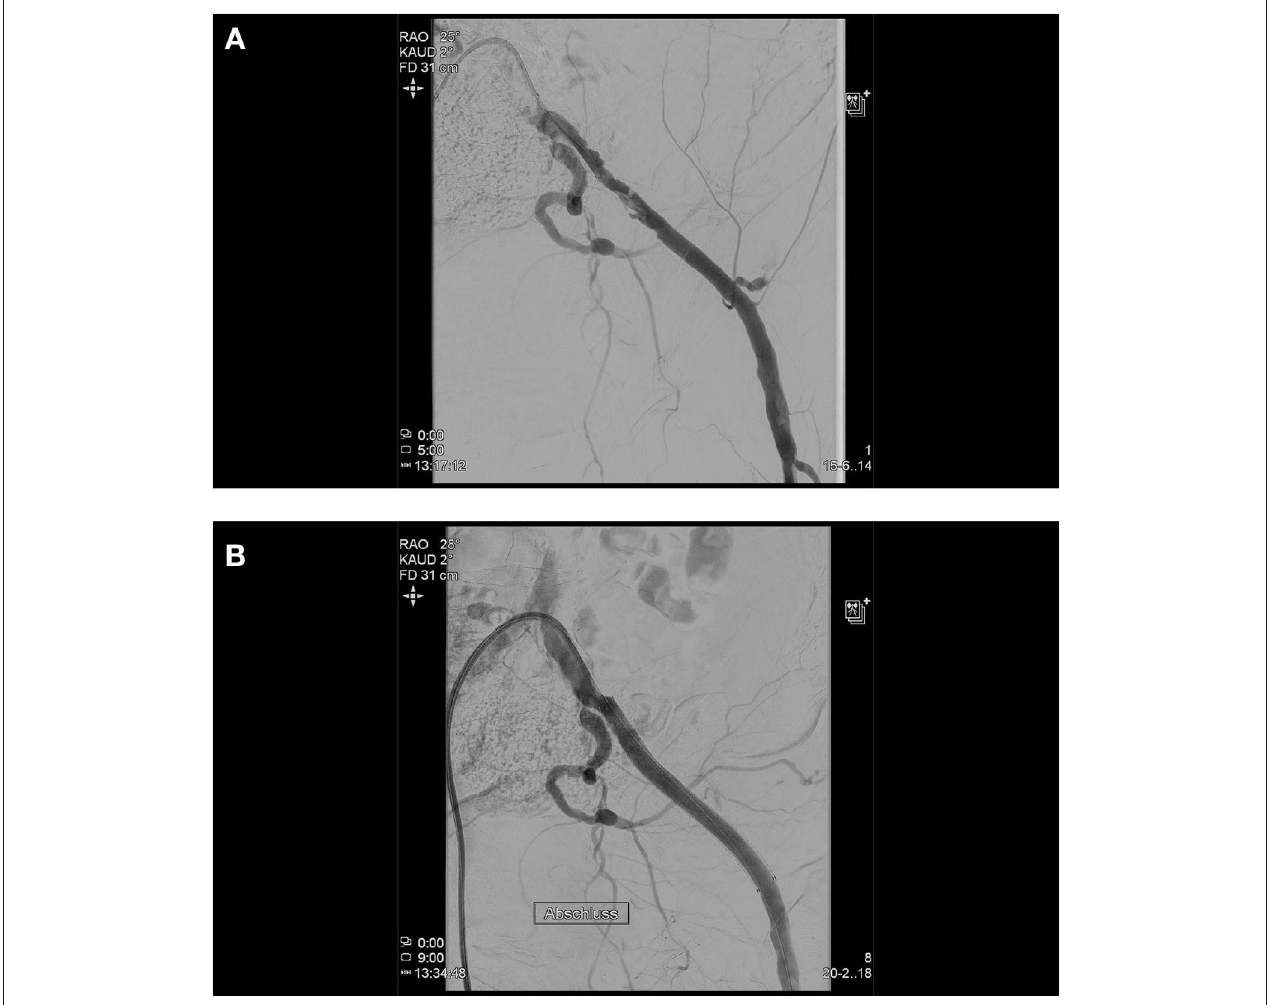
FIGURE 5 | During the TAVI procedure, both the femoral arteries were punctured and cannulated with a 5F sheath left and a 14F sheath on the right side. After successful implantation of the TAVI device, right femoral puncture site was successfully closed using two previously administered Perclose ProGlide TM (Abbott) systems. The 5F sheath on the left side was removed and after manual compression for approximately 10min with no overt bleeding, the lady got a compression bandage and was transferred to our immediate care unit. After 30min, she developed an acute ischemia of the left leg, which improved after relaxation of the pressure dressing. Then, the lady developed a hemorrhagic shock and was set on volume expansion and inotropes. The immediate right femoral crossover angiography shows, in addition to a dissection of the left external iliac artery, an active bleeding from the left hypogastric artery caused by the initial puncture and the sheath (A) . Using a 45cm 7F sheath (Destination Guiding Sheath, Terumo), the bleeding site was blocked utilizing an 8.0mm × 40mm balloon (Mustang TM , Boston Scientific) and an 8.0mm × 100mm covered stent prothesis (Gore ® Viabahn ® Endoprosthesis, Gore) was implanted which sealed both, the hypogastric bleeding and external iliac dissection (B)